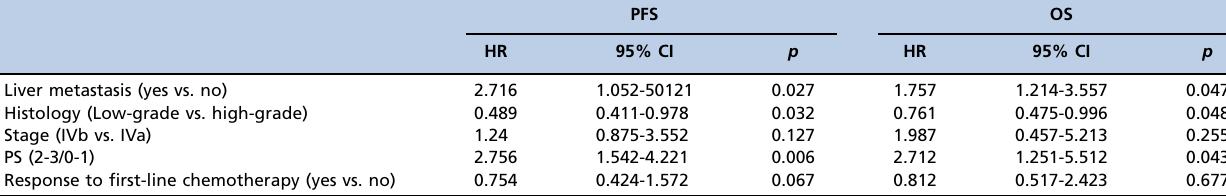
Liver metastasis (yes vs.